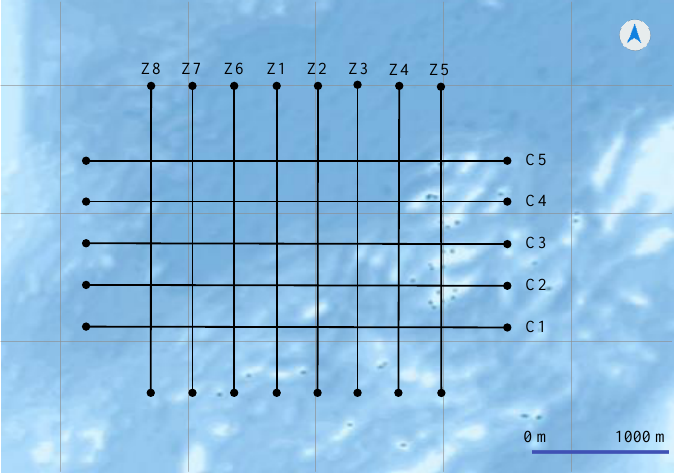
Figure 11. The parallel survey lines in an intelligent vessel navigation system.